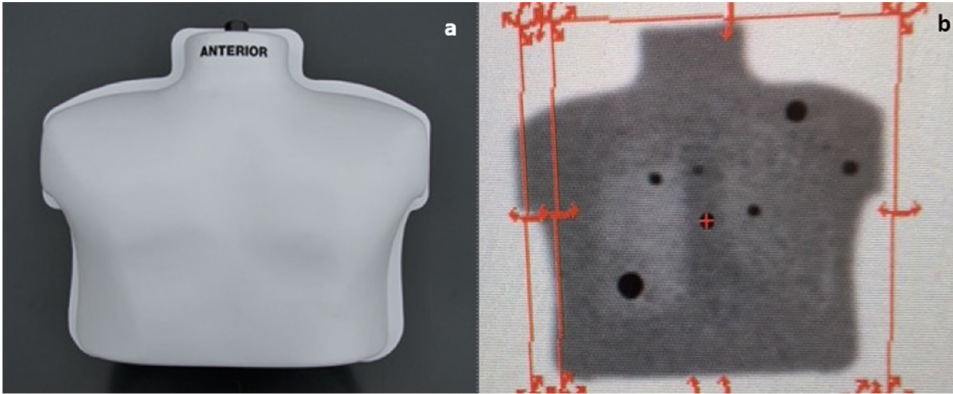
Figure 1. PET calibration phantom model. ( a ) Thoracic phantom model; ( b ) appearance of calibra- tion model on PET-CT demonstrating 6 FDG containing spheres in a dilute FDG solution. model on PET-CT demonstrating 6 FDG containing spheres in a dilute FDG